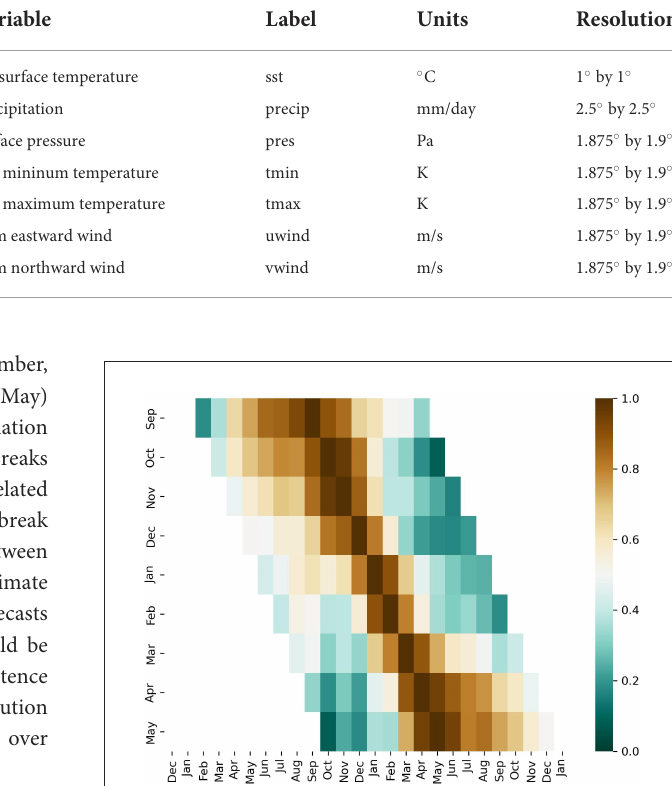
FIGURE2 Persistence of malaria incidence. A cross-correlation of malaria incidence for various reference months. Correlation is indicated in color. For a specific month (y-axis) the correlation of malaria incidence with respect to other months are shown along the